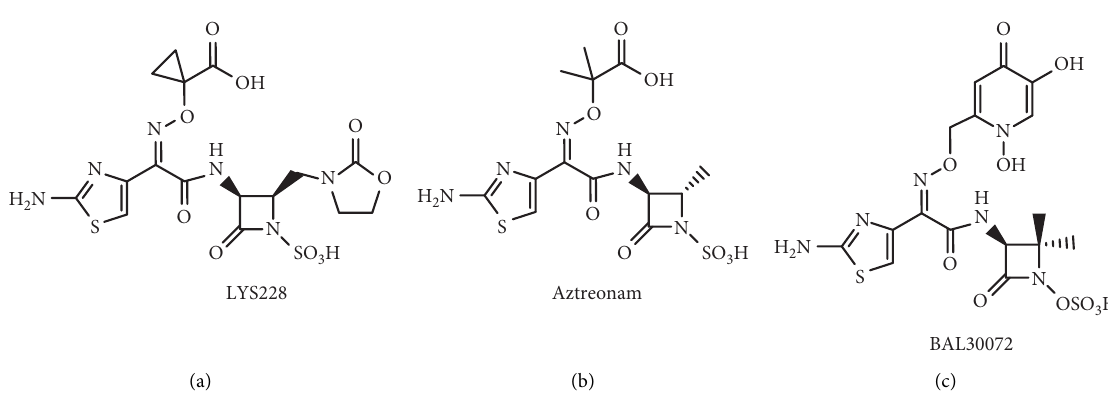
Figure 1: Structures of currently approved aztreonam and other monobactams in clinical